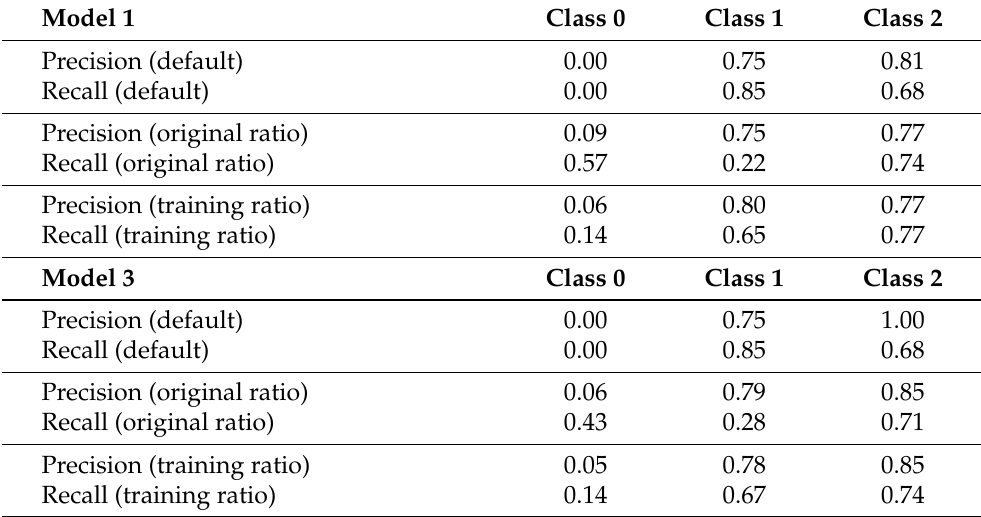
Table 24. Precisions and recalls for models 1, 3, and 5 with correcting vectors